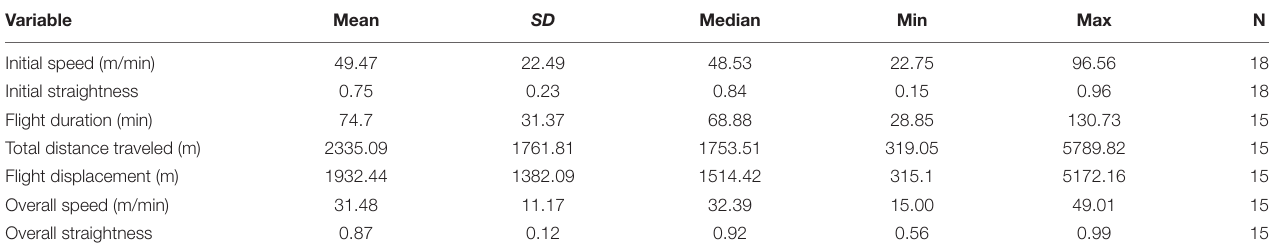
TABLE 2 | Overview of the flight variables with the mean, standard deviation (SD), median, min, max, and number of observations (N). Variable